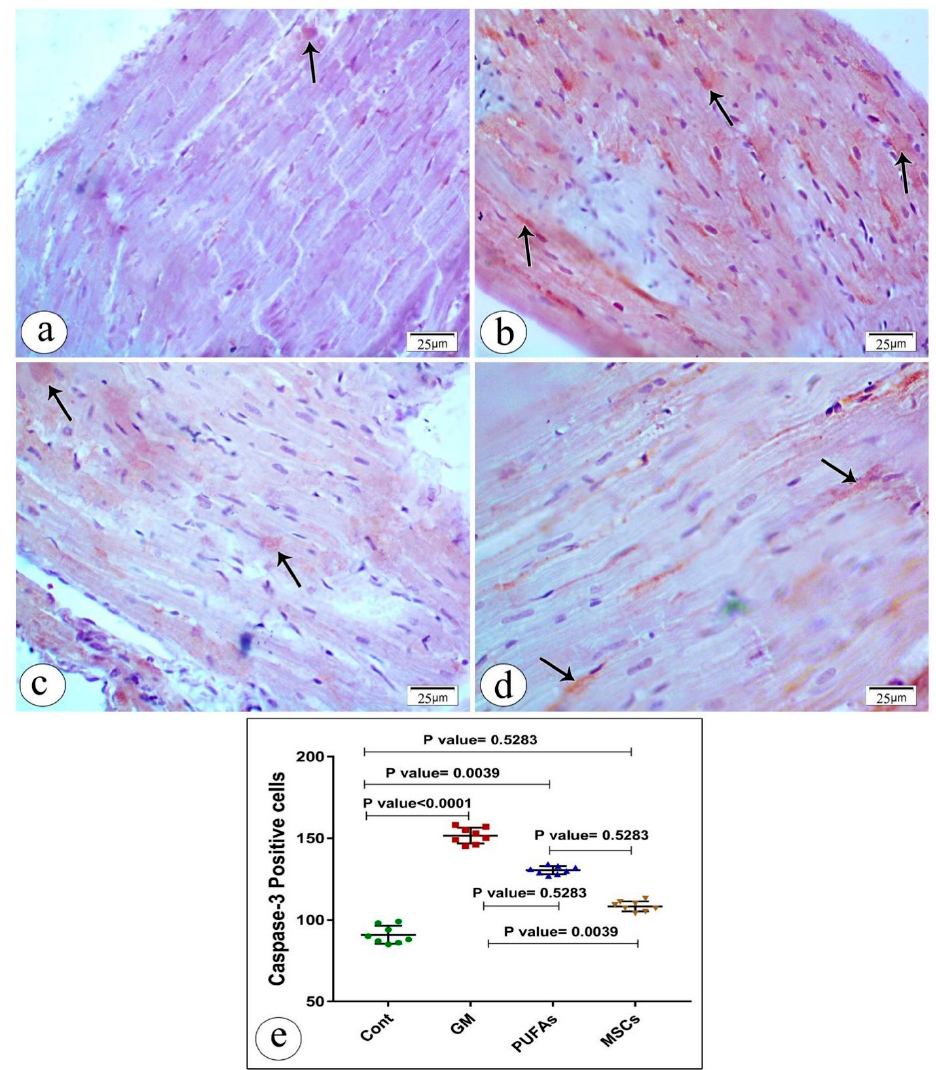
Figure 6. Immunostained sections of heart tissue stained with caspase-3 antibody: ( a ) control group showing mild positive caspase-3 immunostaining in the sarcoplasm of the muscle fibers (arrow); ( b ) gentamycin-treated group showing highly positive caspase-3 immunostaining in the sarcoplasm of the muscle fibers(arrow); ( c ) gentamycin- and PUFA-treated group showing moderate positive caspase-3 immunostaining in the sarcoplasm section in the cardiac muscle of control group(arrow); ( d ) gentamycin- and MSC-treated group showing moderate to mild positive caspase-3 expression with lower caspase-3 expression than the gentamycin group(arrow). ( e ) Statistical analysis of caspase intensity in cardiac myocytes in all groups studied. Nonparametric statistics were used. Data were analyzed using the Kruskal–Wallis test followed by Dunn’s test. Results are expressed as medians and interquartile ranges. Differences were considered significant at p < 0.05.